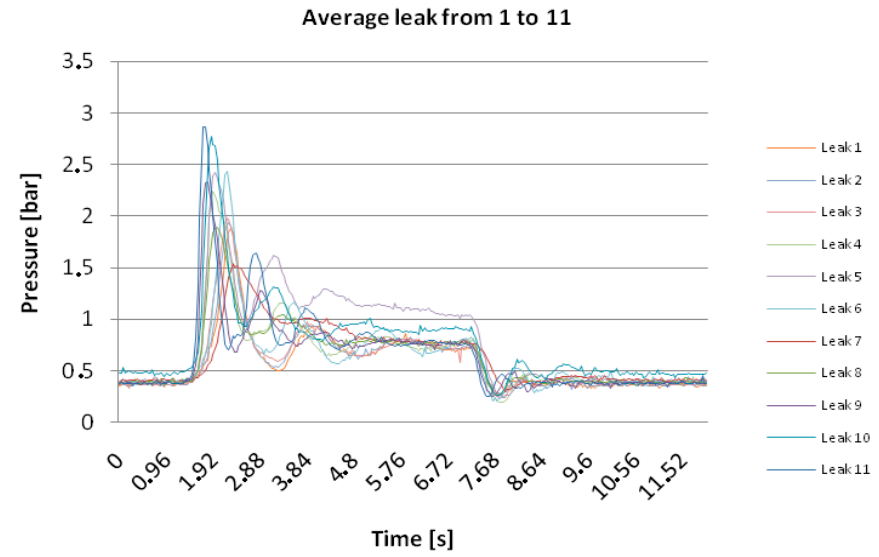
Figure 10. Correlation between different peaks and leak locations.